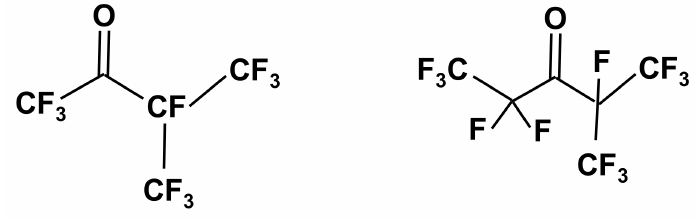
Figure 5. Molecular structure of two fluoroketones, C 5 F 10 O ( left ) C 6 F 12 O ( right